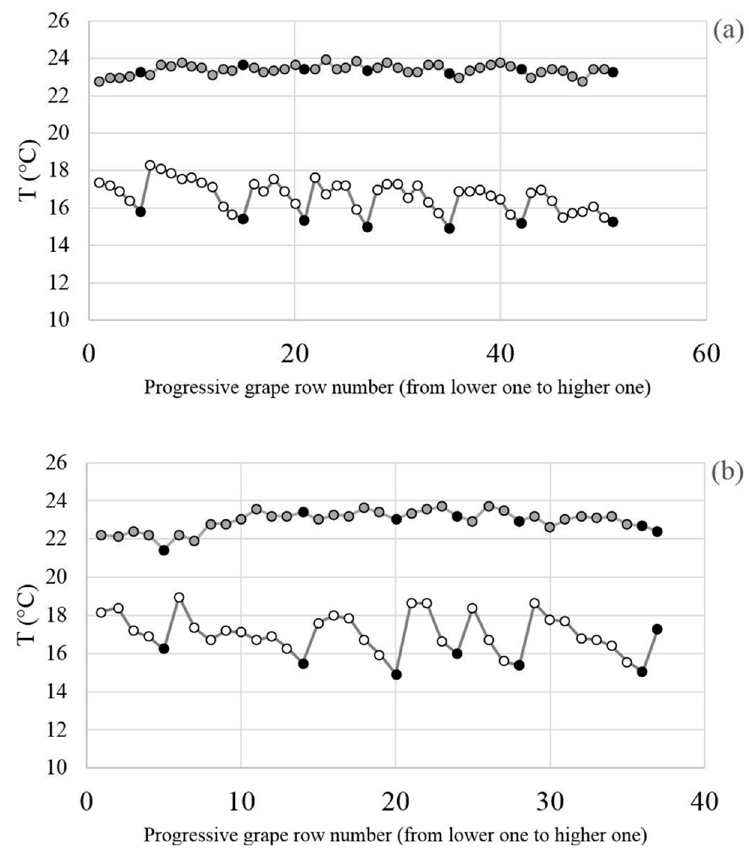
Figure 8. Temperature average values along the hillside terraced Grospoli vineyard. ( a ) North area; ( b ) South area. White and grey timeseries represent morning and afternoon temperatures respectively. Black dots represent internal rows temperature mean